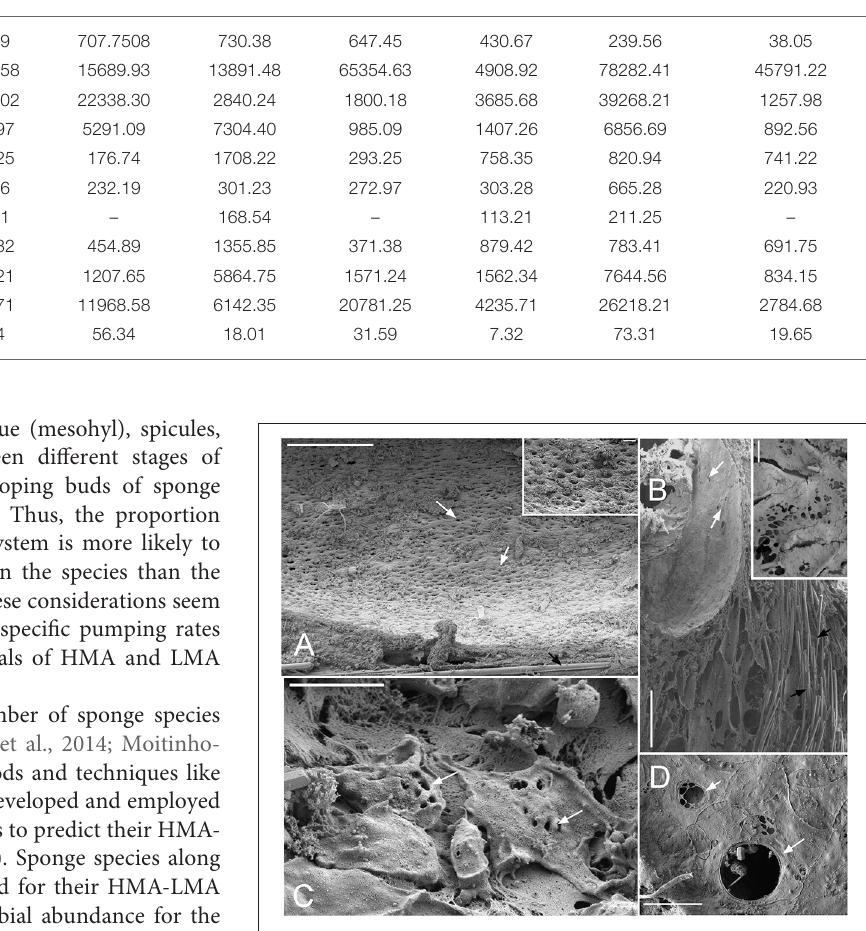
FIGURE 7 | SEM images showing the ostia (A) Cinachyrella cf. cavernosa the incurrent pores, ostia, are present in rounded depression/pits of the porocalices on the lateral surfaces along the base of the sponge. Inset magnified view of the ostia. (B) For the buried growth form of Biemna fortis, the ostia present on the fistules/finger-like projection growing above the ground. Inset magnified view of ostia (C) Suberites carnosus porocytes with ostia (D) Amorphinopsis foetida ostia. The white arrows point to the ostia. Scale bars: (A) 500 µ m, inset = 50 µ m; (B) 500 µ m, inset 50 µ m; (C) 20 µ m; (D) 5 µ